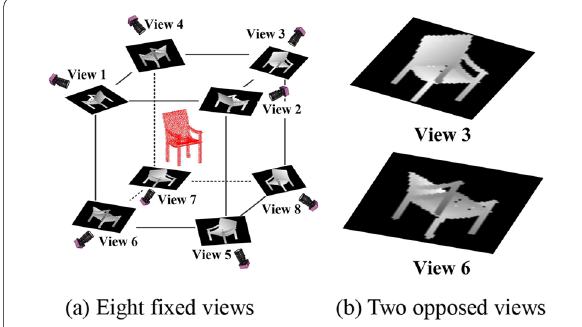
Figure 7 The fixed views are scattered at 8 corners of a